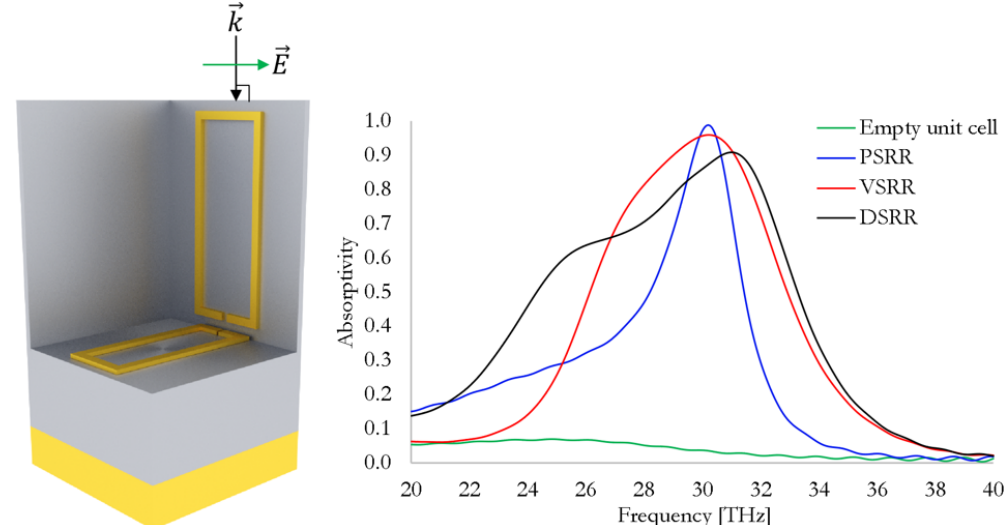
Figure 4. ( left ) The dual split-ring resonator (DSRR) unit cell geometry is illustrated. ( right ) Spectral absorption is plotted for the case of an empty unit cell, a unit cell containing a single PSRR, a unit cell containing a single VSRR, and a unit cell containing both a VSRR and PSRR. Note the widening of the absorption band in the DSRR case.